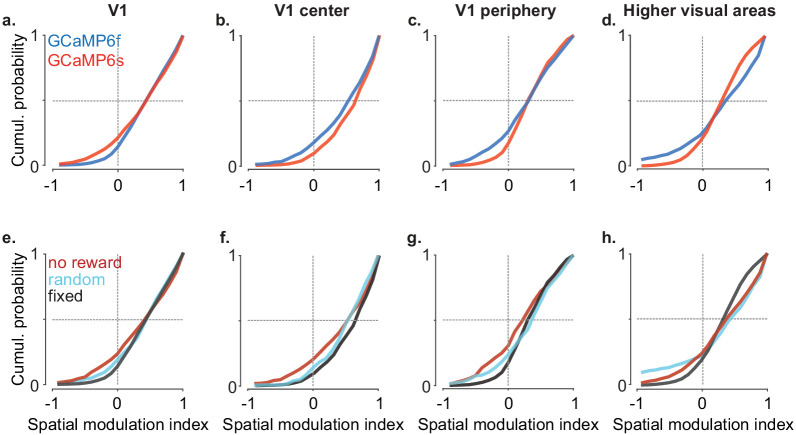
Spatial modulation does not depend on reward or mouse line.(a) Cumulative distribution of the spatial modulation index (SMI) in even trials for V1 split by Ca2+ indicator, GCaMP6f or GCaMP6s (median ± m.a.d. of SMI: 0.43 ± 0.34 vs. 0.43 ± 0.29). (b) As in (a) for V1 neurons with central receptive fields (median SMI: 0.53 ± 0.31 vs 0.64 ± 0.25). (c) As in (a) for V1 neurons with peripheral receptive fields (median SMI: 0.31 ± 0.31 vs. 0.29 ± 0.24). (d) As in (a) for all higher visual areas (HVAs) combined (median SMI: 0.40 ± 0.37 vs. 0.34 ± 0.24). (e) Cumulative distribution of the SMI in even trials for V1 split by reward condition, no reward, fixed reward at the end of corridor, and reward delivered at random locations (median ± m.a.d. of SMI: 0.42 ± 0.37, 0.43 ± 0.29, 0.44 ± 0.30 respectively). (f) As in (e) for ‘V1 center’ (median SMI: 0.53 ± 0.34, 0.63 ± 0.25, 0.52 ± 0.25;). (g) As in (e) for ‘V1 periphery’ (median SMI: 0.20 ± 0.34, 0.29 ± 0.24, 0.36 ± 0.29). (h) As in (e) for all HVAs (median SMI: 0.33 ± 0.40, 0.35 ± 0.24, 0.48 ± 0.27).